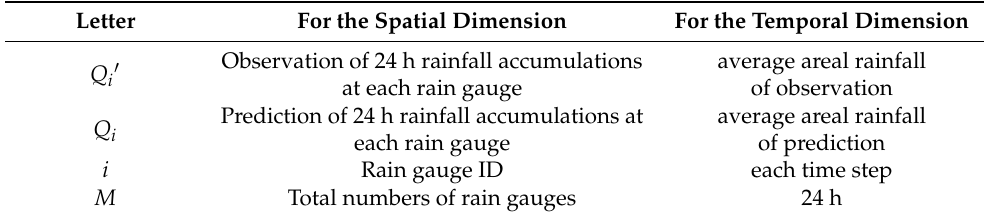
Table 7. The meaning of letter in formulas, including Q i (cid:48) , Q i , i , and M .